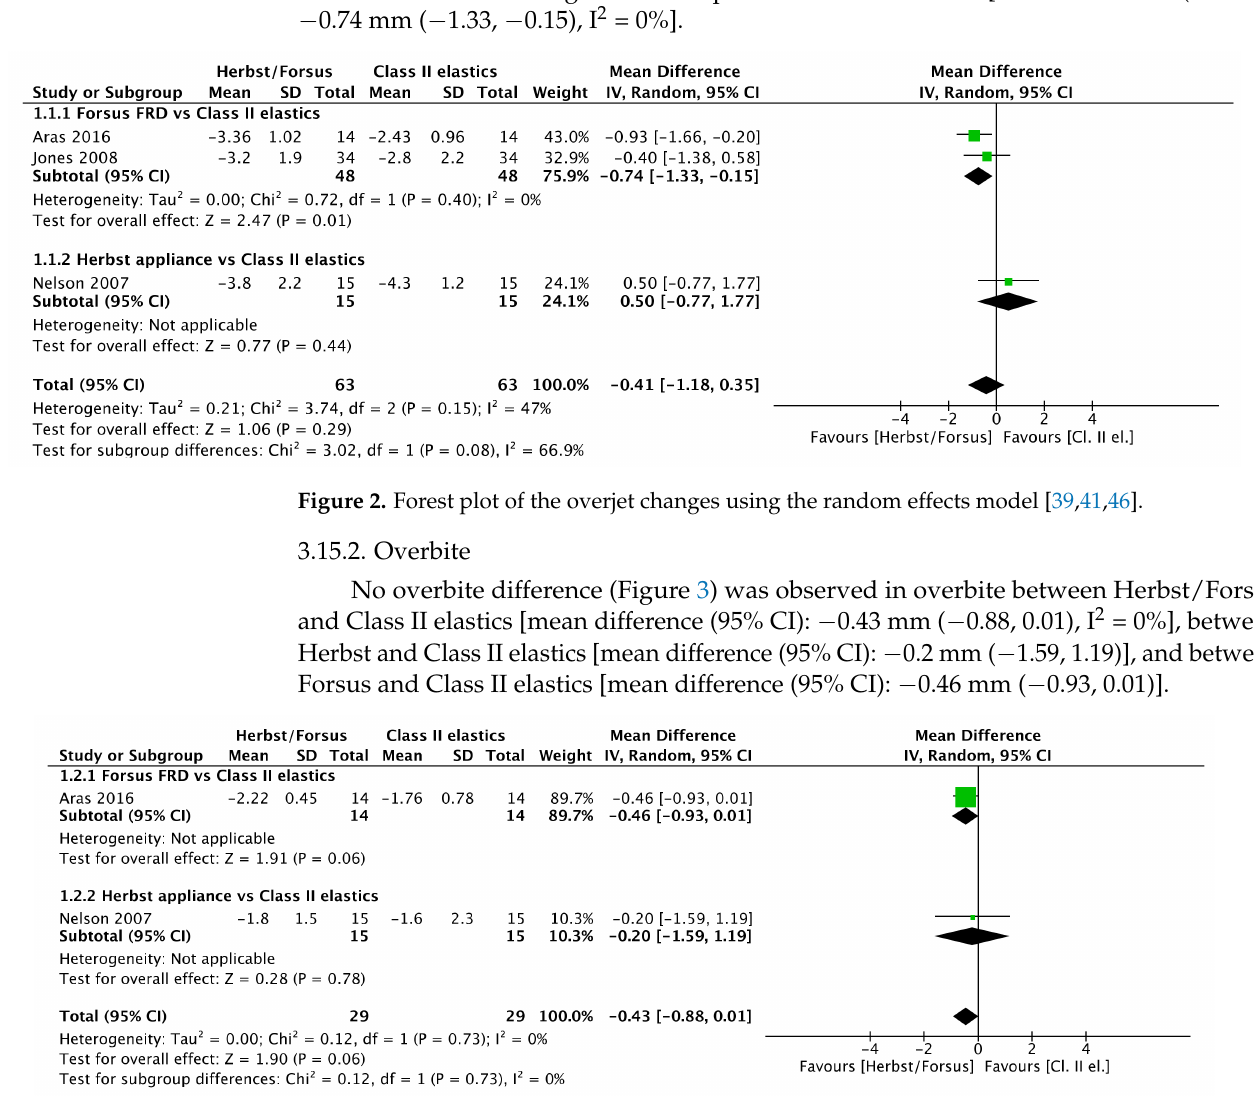
Figure 3. Forest plot of the overbite changes using the random effects model